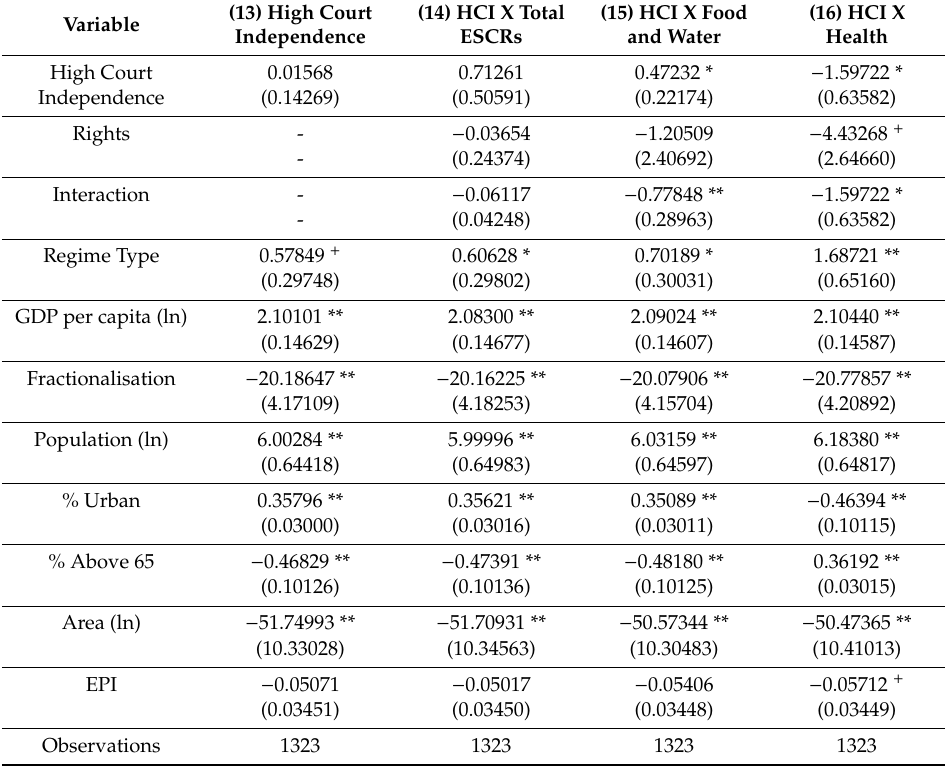
Table 5. High Court Independence, ESCRs, & Basic Water Access, 2000–2015.